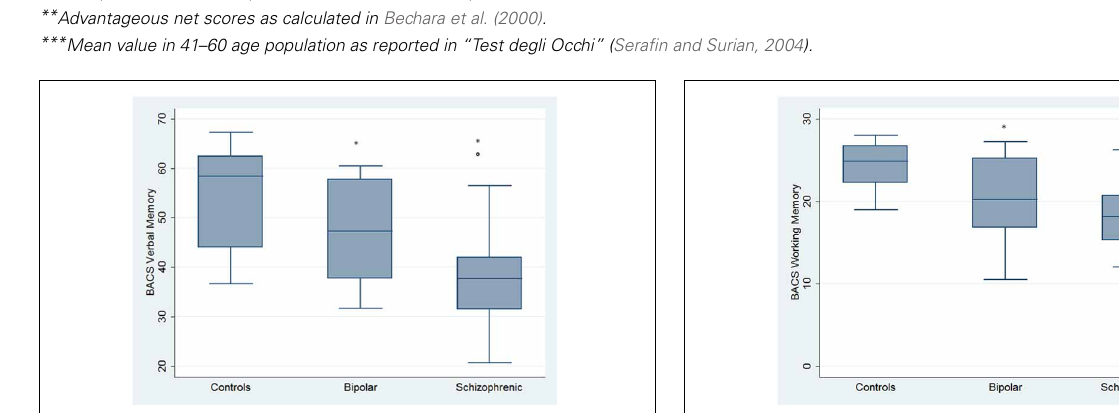
for SKZ: z = 3 . 819, p = 0 . 0001) ( Figure 8 ), failed to complete a greater number of tasks (for BD: z = − 3 . 614, p = 0 . 0003;